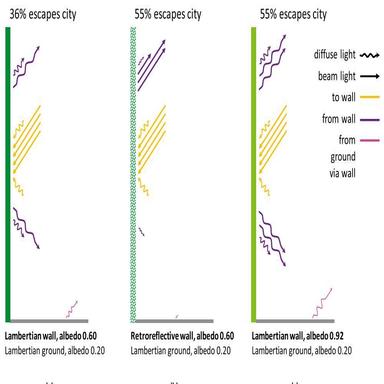
Retroreflective cool surfaces can help sunlight that strikes walls escape the city. The out-of-city reflection from a retroreflective isolated wall of albedo 0.60 (panel b) will be more than 50% greater than that from a Lambertian isolated wall of the same albedo (panel a), and will equal that from a Lambertian isolated wall of albedo 0.92 (panel c).